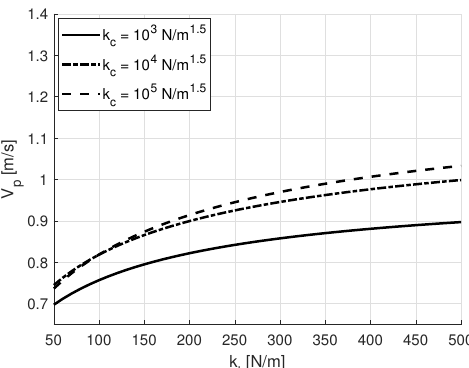
Figure 18. Effects of the impulses of the damping and elastic forces on the final velocity of the object with e = 0.1.